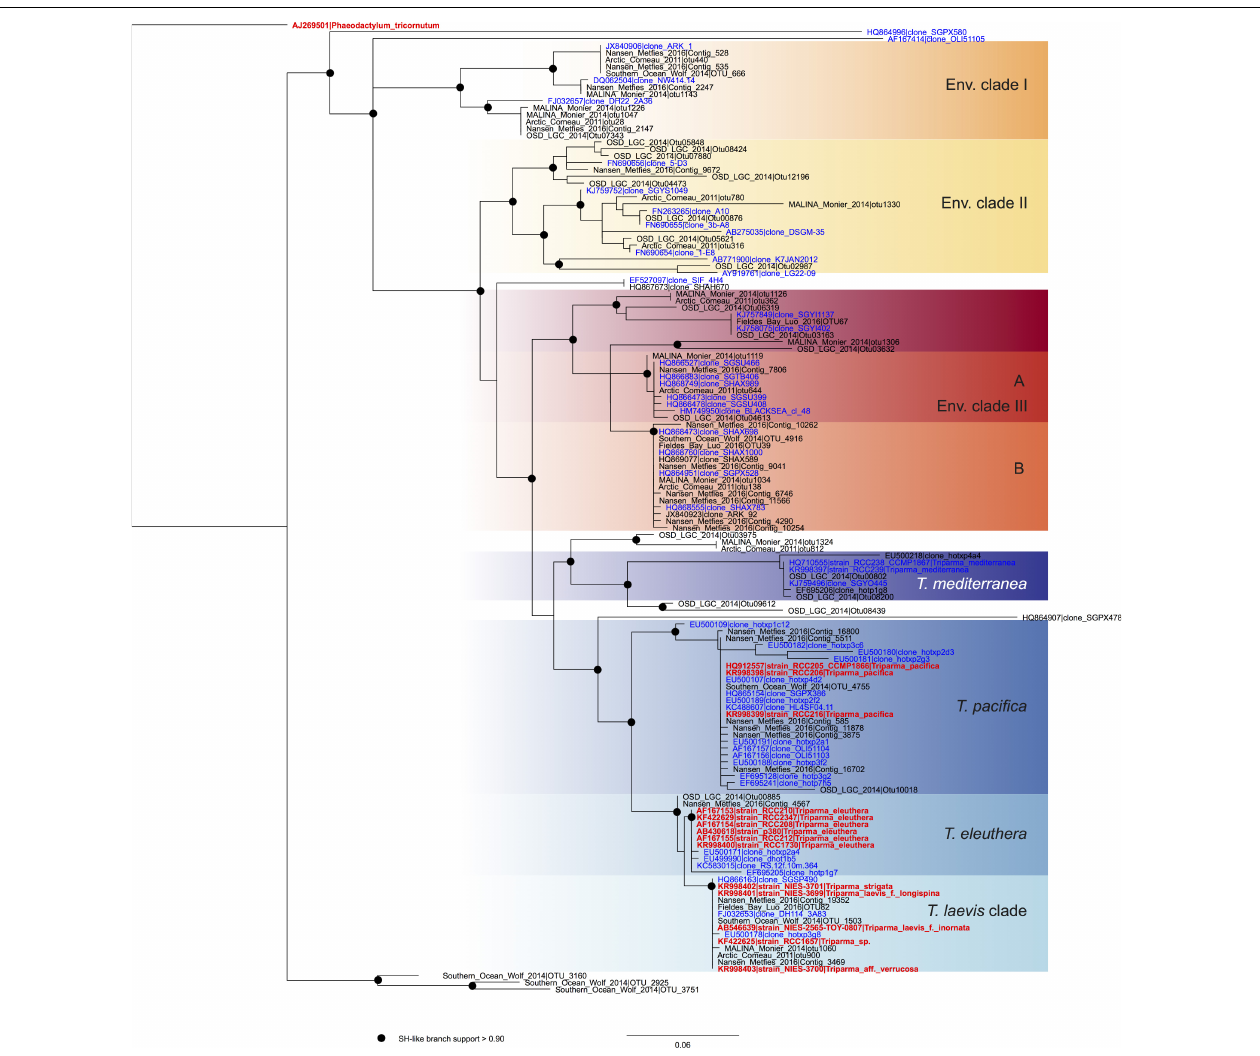
FIGURE 2 | ML phylogenetic tree based on the V4 region of the 18S rRNA gene based both on GenBank sequences available from the PR 2 database (Guillou et al., 2013) and on metabarcodes OTUs obtained from the studies listed in Table 2 (see Methodology in Supplementary Material ). The tree was constructed with phyML and dots correspond to nodes with SH-like branch support > 0.90. GenBank sequences from environmental samples are colored in blue and those from cultures, in red.